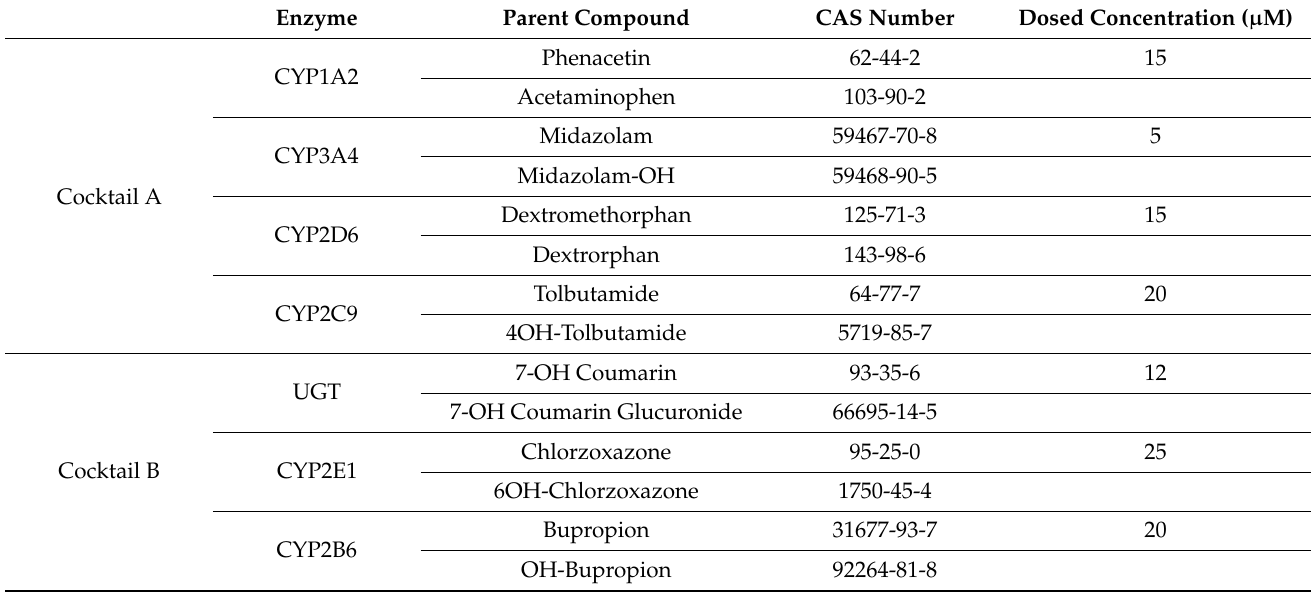
Table 3. Information on enzyme activity